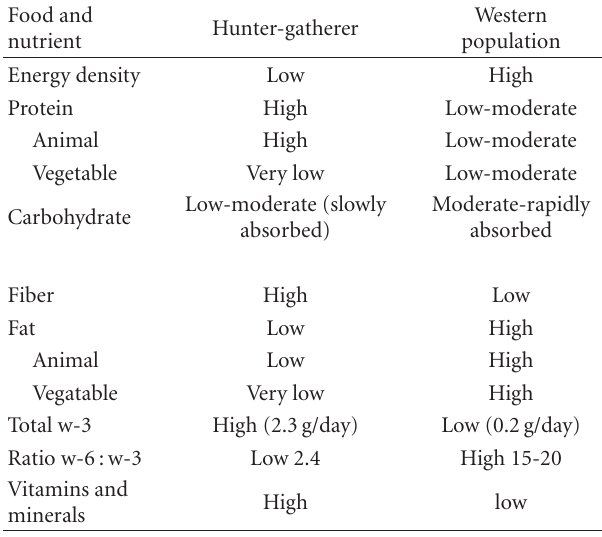
Table 1: Food and nutrient intake among hunter-gatherer and western